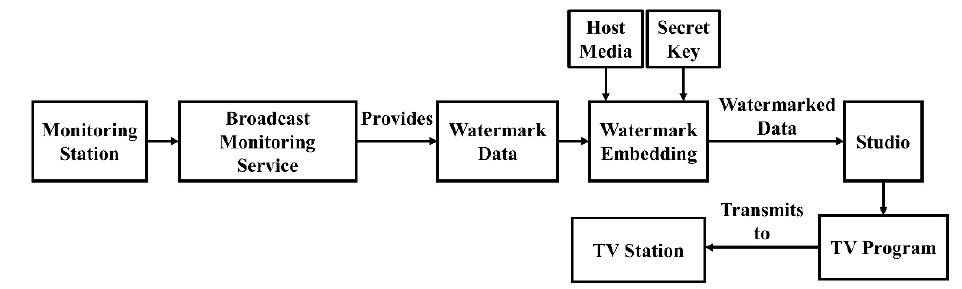
Figure 5. Broadcast monitoring using digital watermarking.